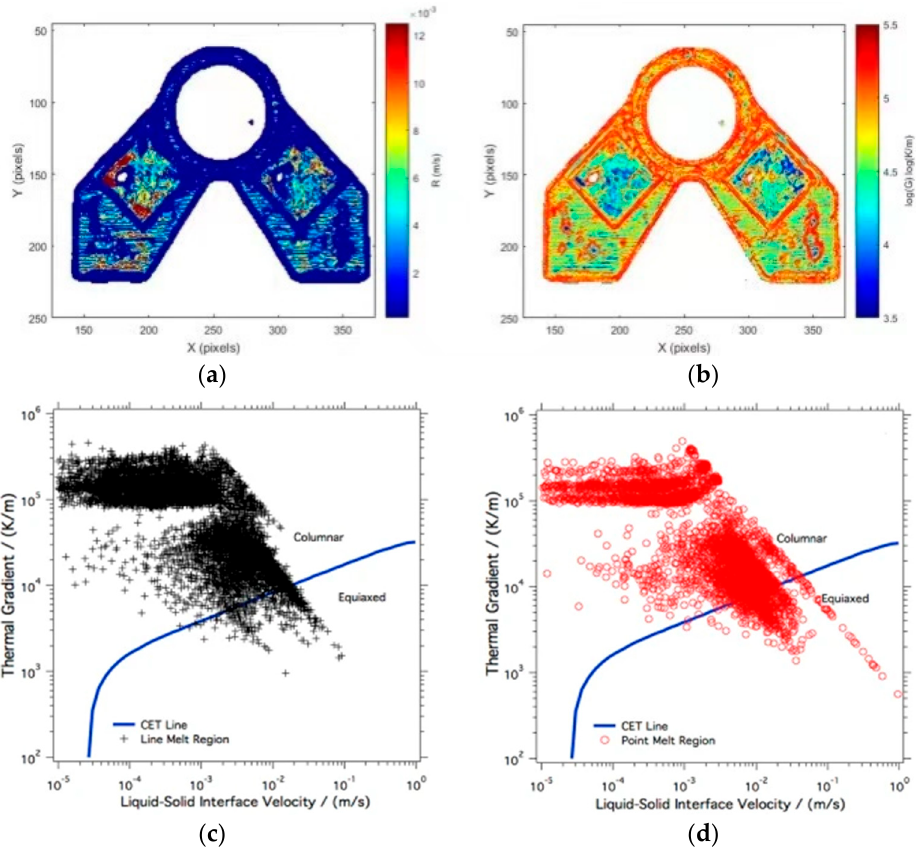
Figure 13. Influence of scan strategies on grain morphology in EBM [52]. ( a ) The layer thermal gradients; ( b ) Interface velocity; ( c ) Grain morphology distribution under line scan strategy; ( d ) Grain morphology distribution under point scanning strategy.